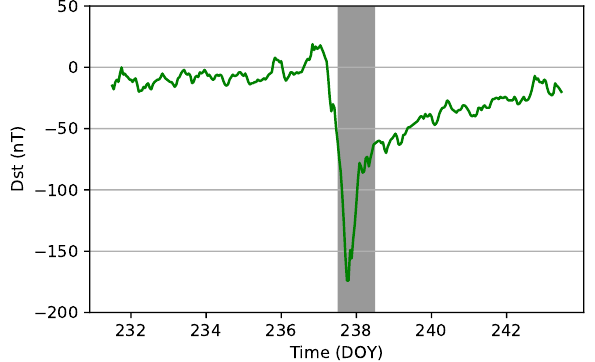
Figure 7. Dst index around DOY 238,